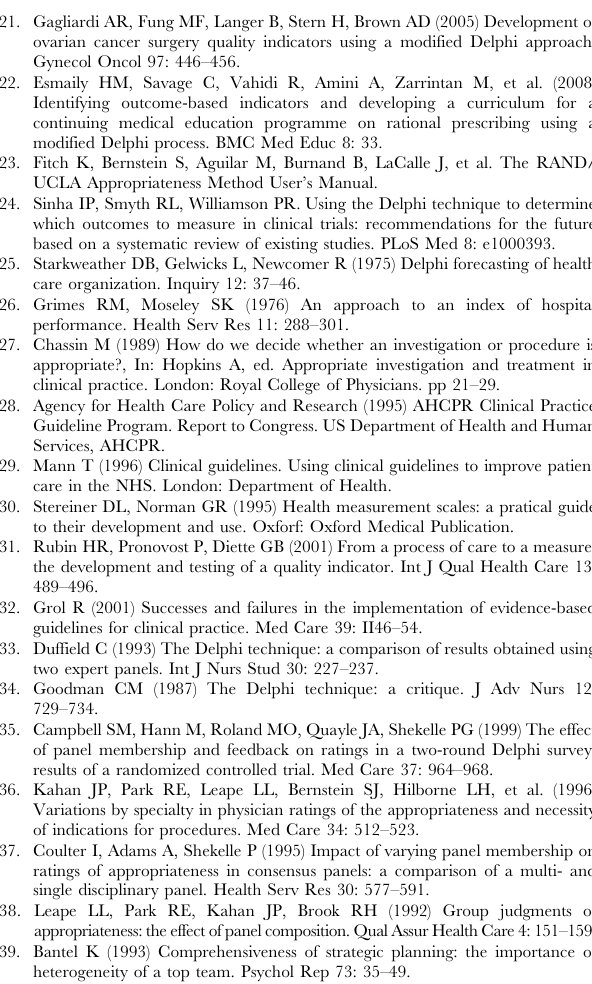
Figure S1 Number of publications per year reporting Delphi procedures used to select quality indicators in healthcare. (DOC) Table S1 Other criteria used to select quality indicators. (DOC) Table S2 Other Criteria used to choose potential participant. (DOC) Box S1 Example of definition of selection